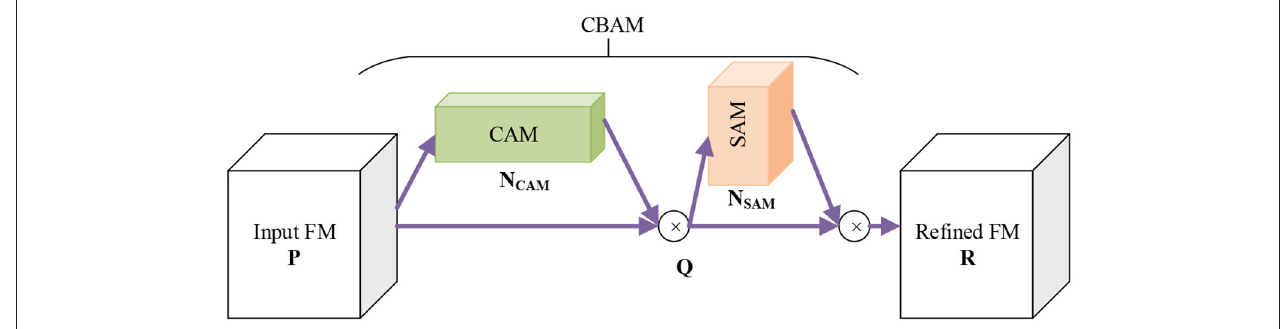
FIGURE 7 | Relation of CBAM and its two